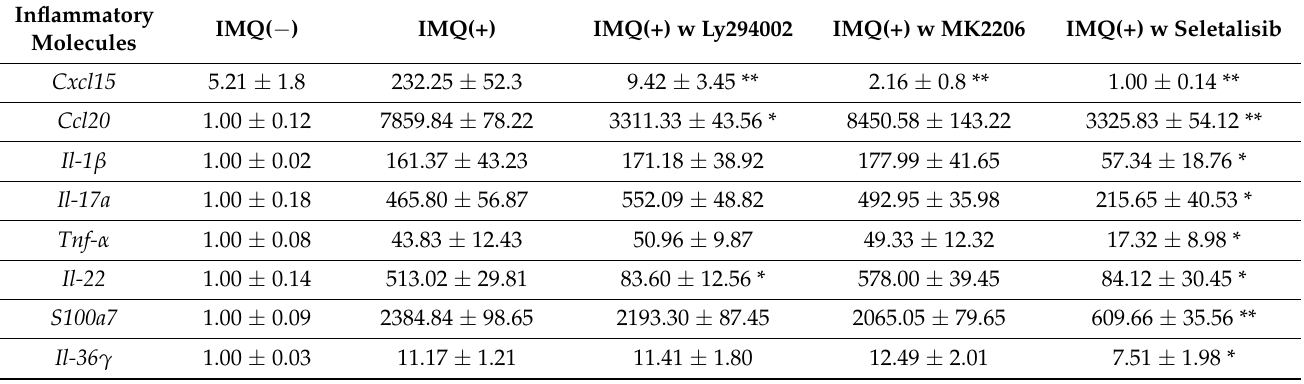
Data reported in table show mean values ± SD obtained from real-time PCR analyses of Cxcl15 , Ccl20 , Il-1 β , Il-17a , Tnf- α , Il-22 , S100a7 , and Il-36 γ performed on pooled mRNA samples of dorsal skin biopsies of mice treated as indicated ( n = 2 mice, Control IMQ ( − ); n = 6